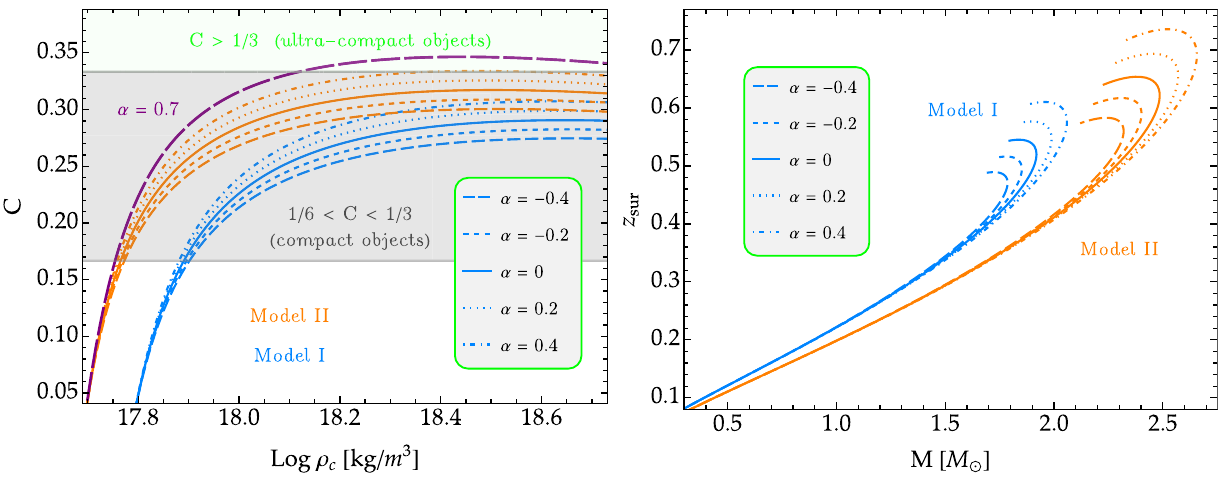
Fig. 4 Left panel: Variation of the compactness with central density for several anisotropic dark energy star sequences. The gray and light- greenstripesrepresentcompactandultra-compactobjects,respectively, according to the classification established by Iyer et al. [92]. Positive anisotropy results in increased compactness for sufficiently high cen- tral densities, while the opposite occurs for negative anisotropy. Note